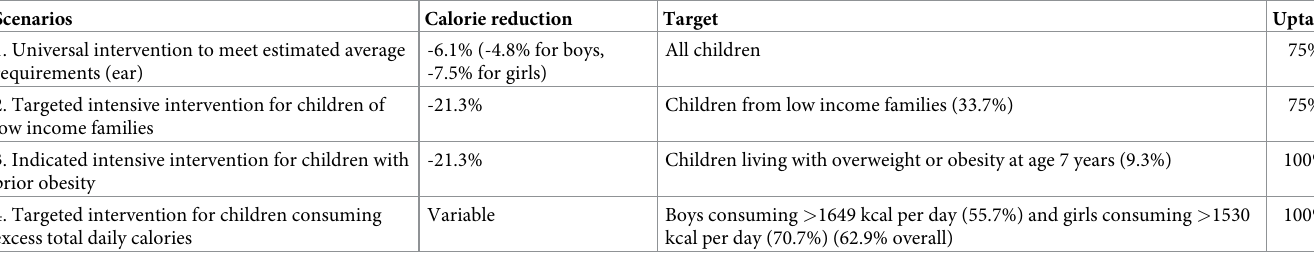
Table 1. Simulated intervention